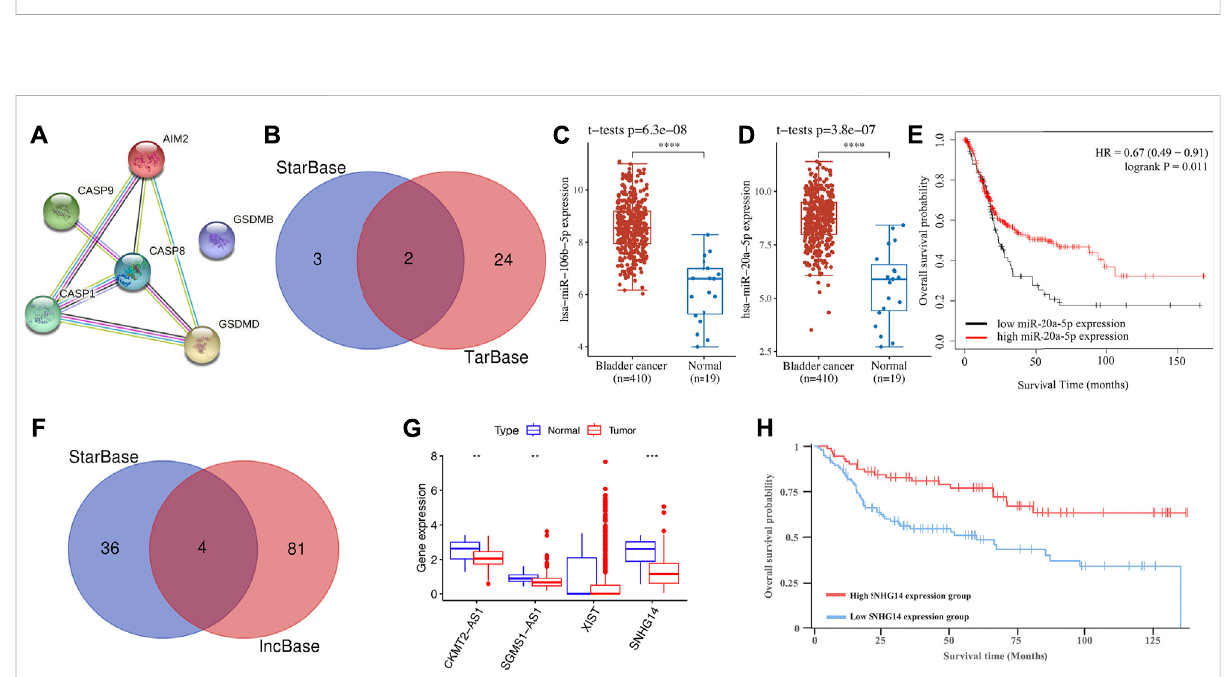
FIGURE 9 Correlation between the risk score and immune cell in fi ltration. (A,B) Risk score showed positive correlation with the abundance of the macrophages M0 and M2. (C – G) As the risk score increased, the abundance of regulatory T cells, follicular helper T cells, CD8 T cells, CD4 memory activated T cells, and activated dendritic cells decreased.